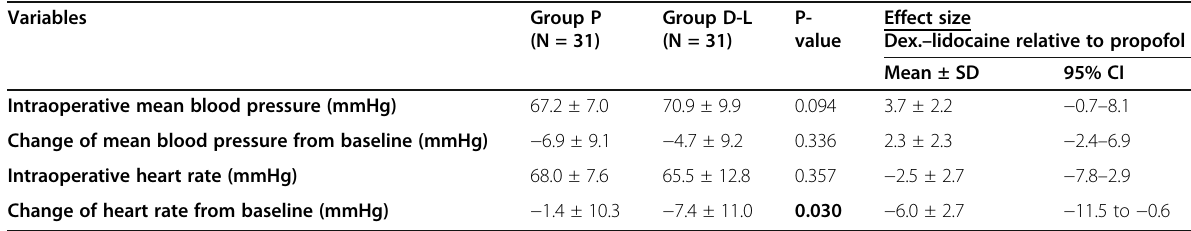
Table 2 Intraoperative blood pressure and heart rate Variables